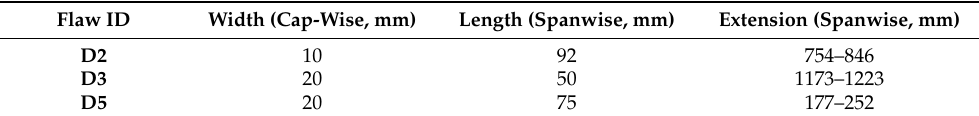
Table 6. Damage characteristics.